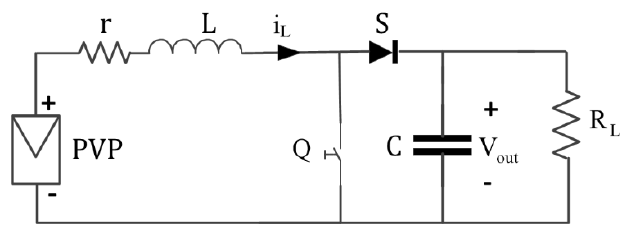
Figure 1. Schematic diagram of the photovoltaic systems (PVS).